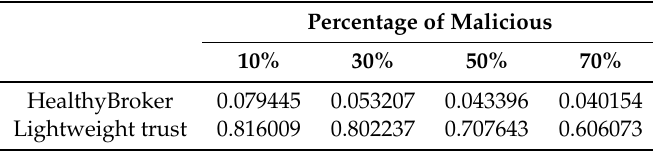
Table 2. MAD results with feedback malicious isolated.